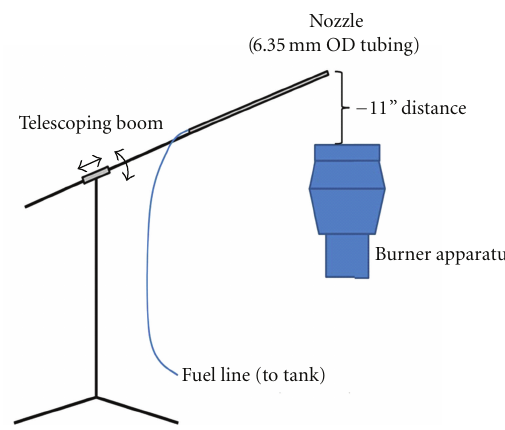
Figure 2: Nozzle on telescoping